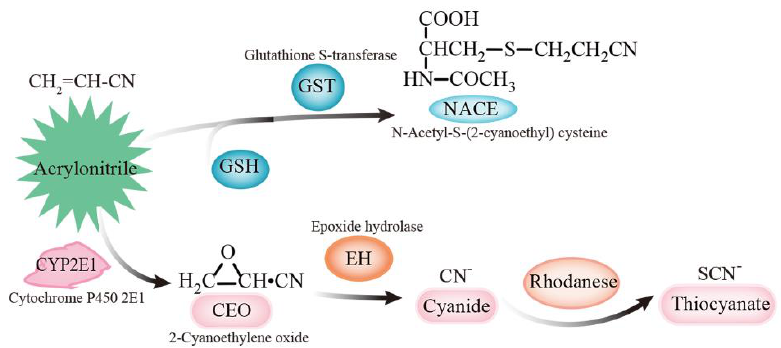
Figure 1. The metabolic pathways of acrylonitrile.